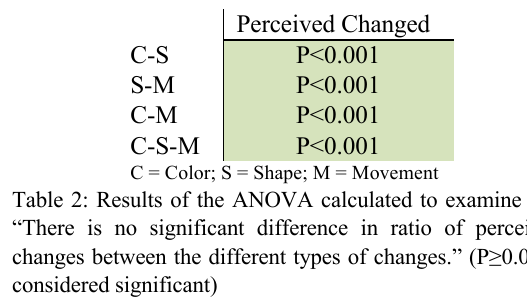
Table 1: Results of the ANOVA calculated to examine H0: “There is no significant difference in the reaction time between the different types of changes.” (P≤0.05 is considered